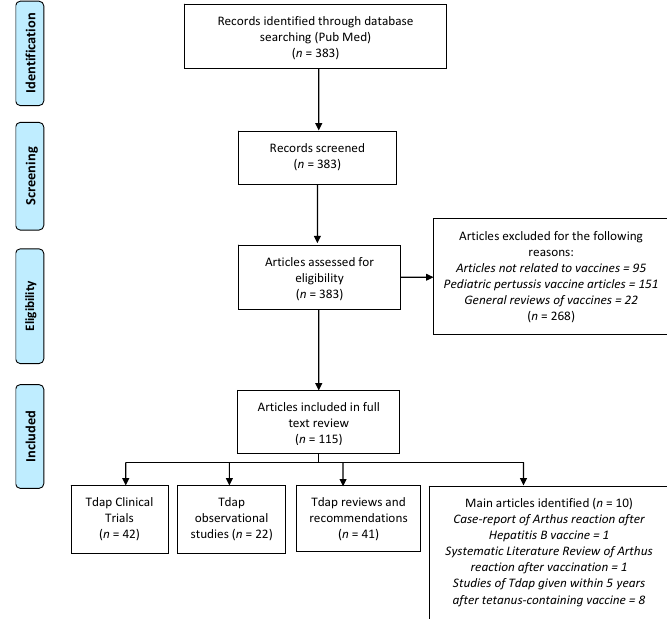
Figure 2. PRISMA flow diagram.